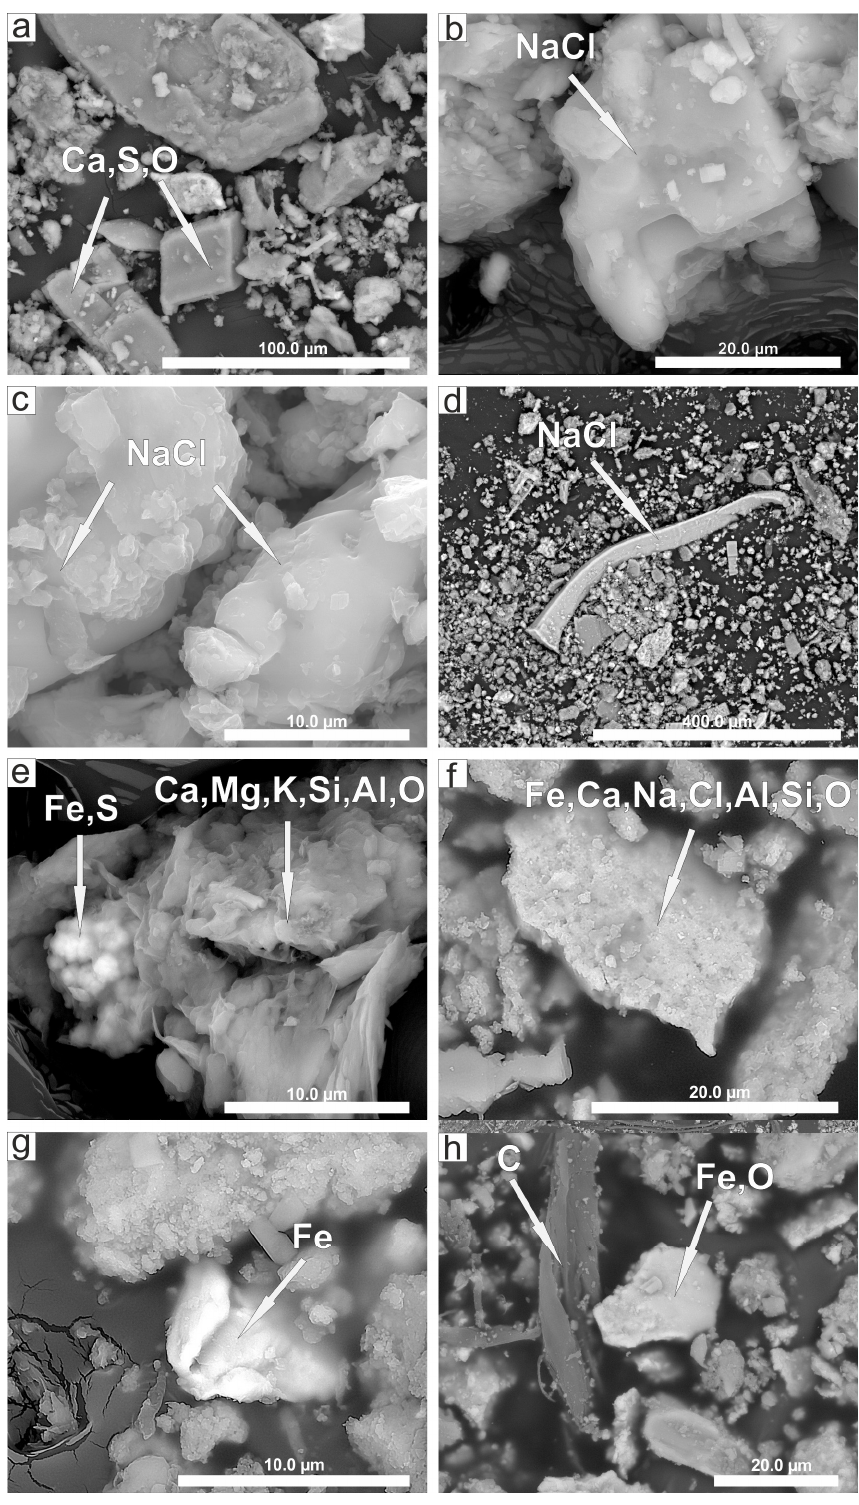
Figure 7. SEM images of individual airborne particles settled in the mine interior. ( a ) Ca-sulfate, I.7; ( b ) NaCl particle I.7; ( c , d ) NaCl particles, I.5; ( e ) Fe sulfide particles embedded in aluminosilicate matrix, I.7; ( f ) ferruginous material adhered to the surface of mineral agglomerates, I.3; ( g ) metalliferous particle, I.3; ( h ) iron oxide and carbonaceous flake, I.3.